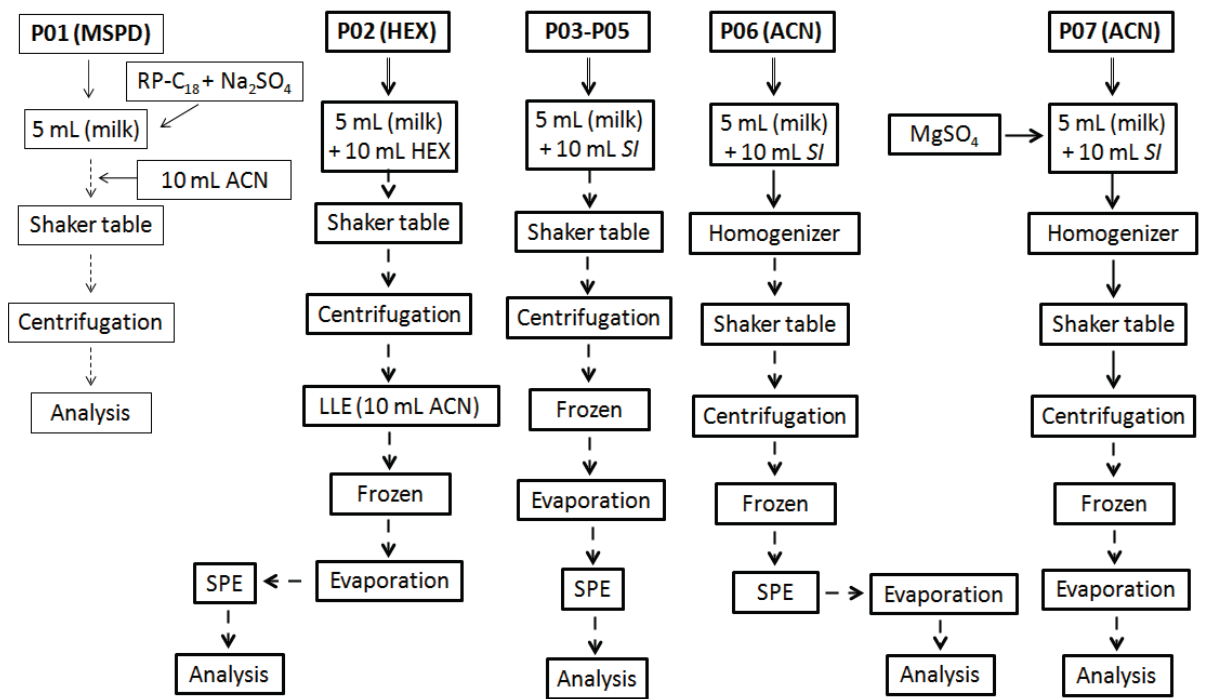
Figure 2. Summary of the procedures evaluated for sample